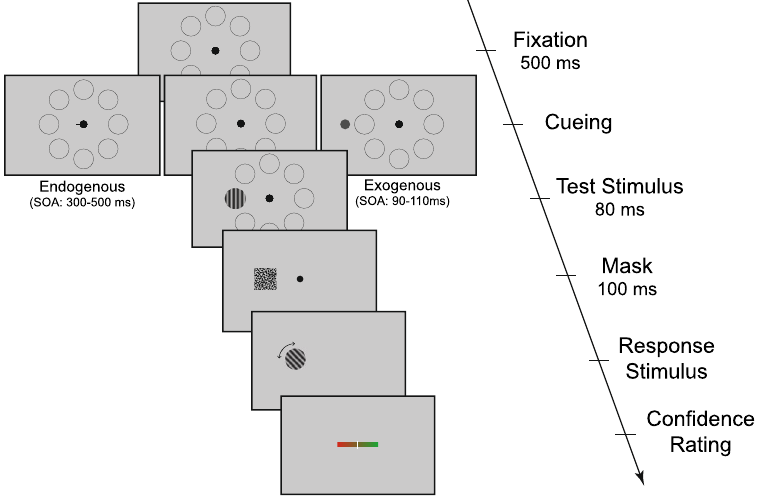
Figure 1. Orientation matching task. Participants attempted to reproduce the orientation of a grating test stimulus using arrow keys to turn the response stimulus. Afterwards they reported the confidence in their decision on a continuous scale, again using arrow keys. During the fixation and cueing period eight grey circles indicated the possible locations at which the grating could appear. The average trial time was the same across the three conditions and the only difference in the trial sequence between conditions was during the cueing period. In the endogenous condition a foveally presented “Posner” line pointed for 300–500 ms to the location where the stimulus would appear. In the exogenous condition a small grey dot was briefly (16 ms) flashed immediately next to the location of the target. Stimulus onset asynchrony (SOA) between cue and target onset was 90–110 ms in the exogenous condition. Both cues were 100%